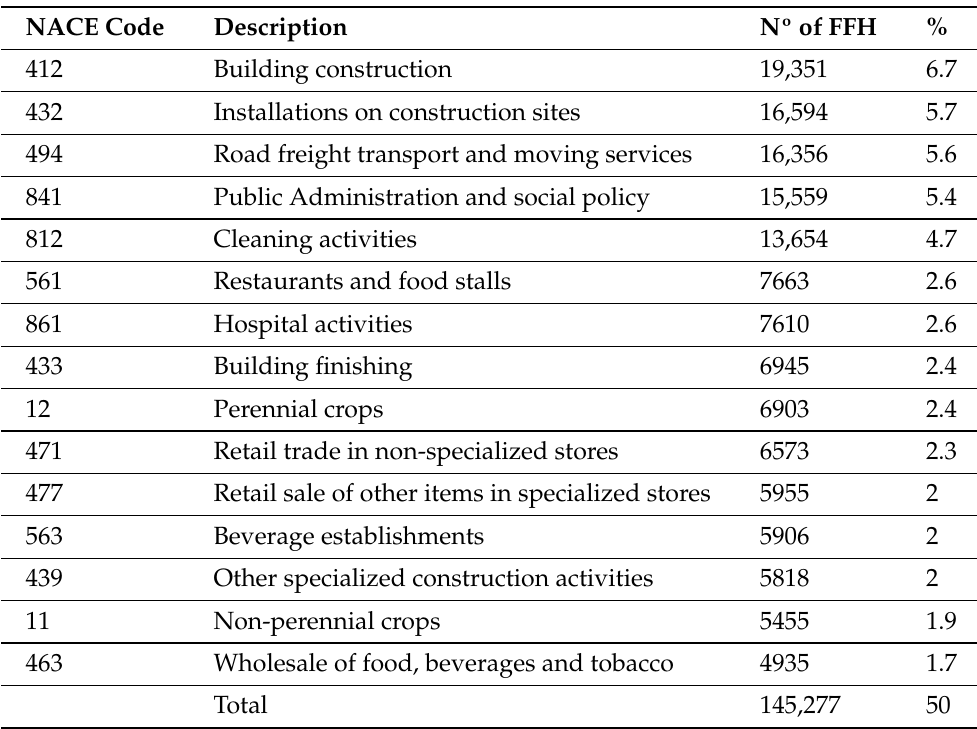
Table 1. Distribution of FFH accidents by NACE